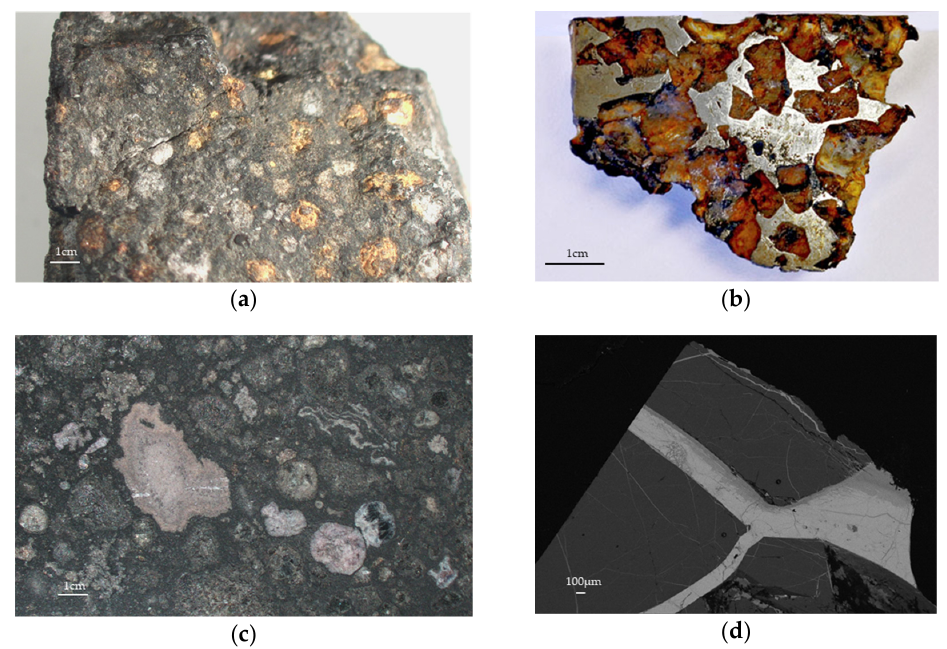
Figure 2. Images of some specimens of the Meteorite collection of the University of Perugia (Italy) at different scales. ( a ) Vigarano; ( b ) Mineo; ( c ) Allende (images acquired by optical microscope); ( d ) Mineo (image acquired by EPMA).